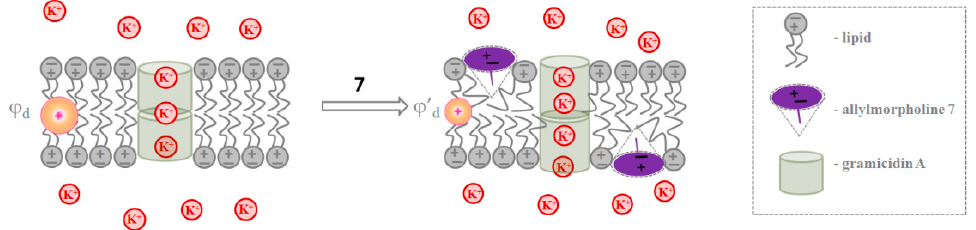
Figure 3. The schematic representations of the mechanisms of the action of allylmorpholine 7 on the conductance of GrA channels via alterations in membrane dipole potential.